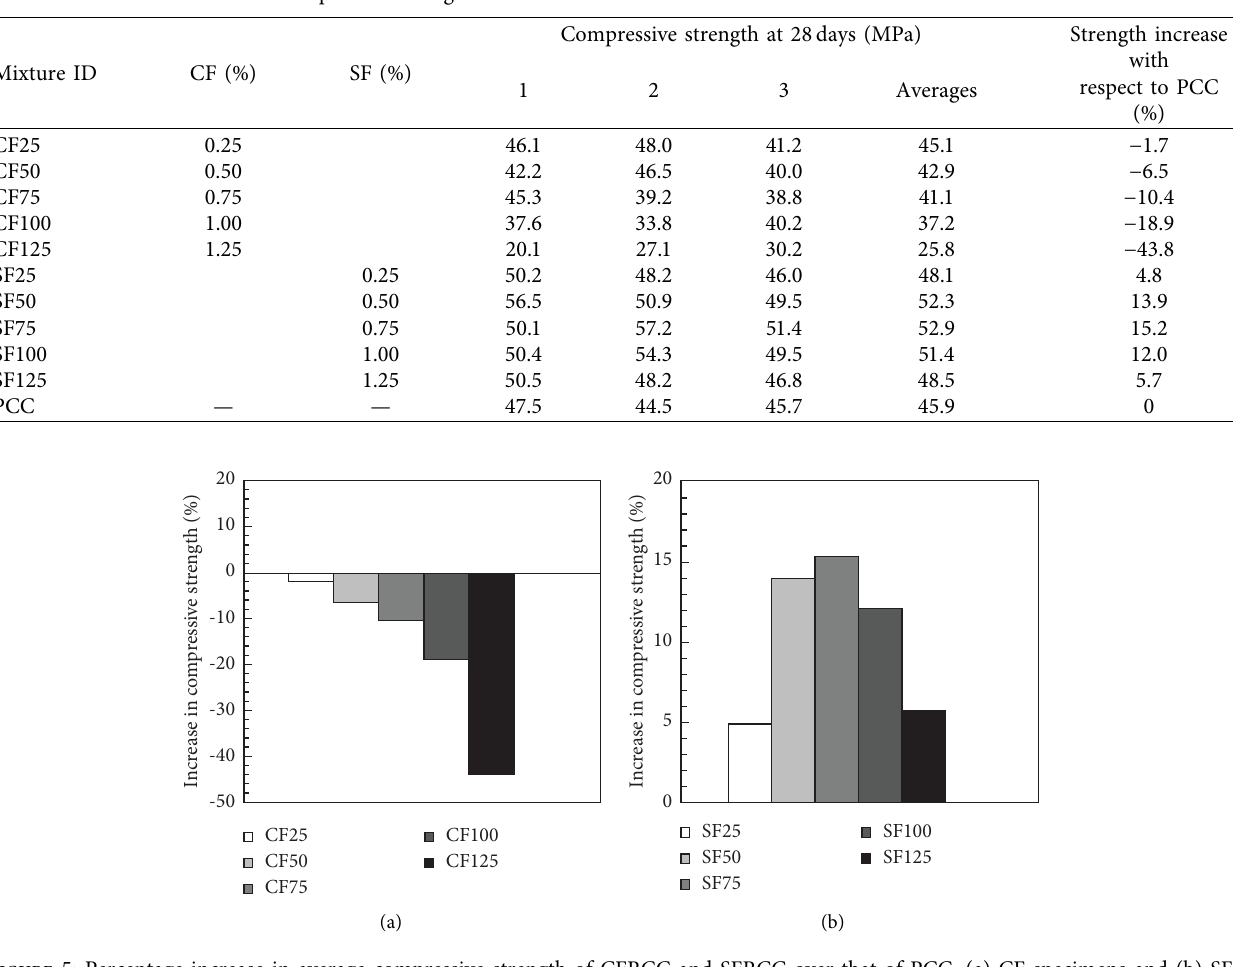
Figure 5: Percentage increase in average compressive strength of CFRCC and SFRCC over that of PCC. (a) CF specimens and (b) SF specimens.